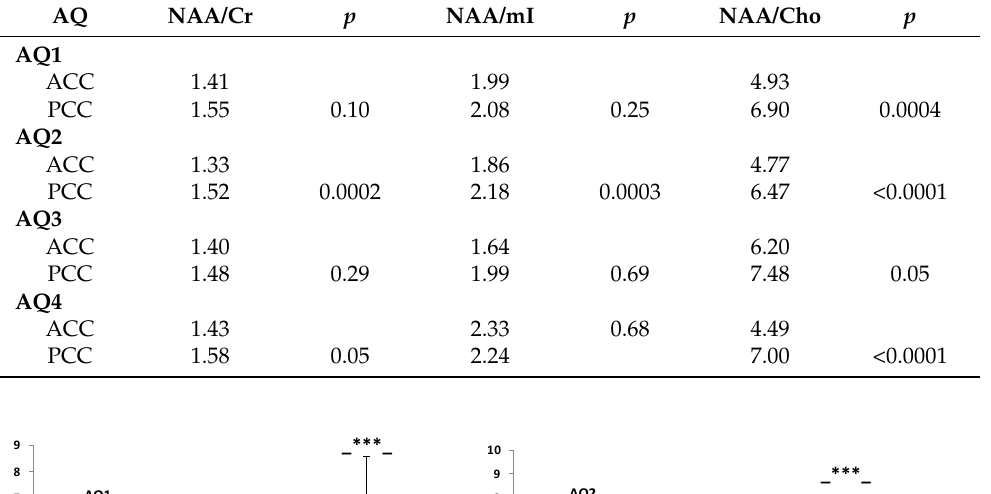
Table 6. Metabolite ratios in the applied AQ threshold (AQ1 = 28.3%, n = 17; AQ2 = 43.3%, n = 26; AQ3 = 10.0%, n = 9; AQ4 = 18.3%, n = 13) to stratify the adults in the ASD and TD groups together.